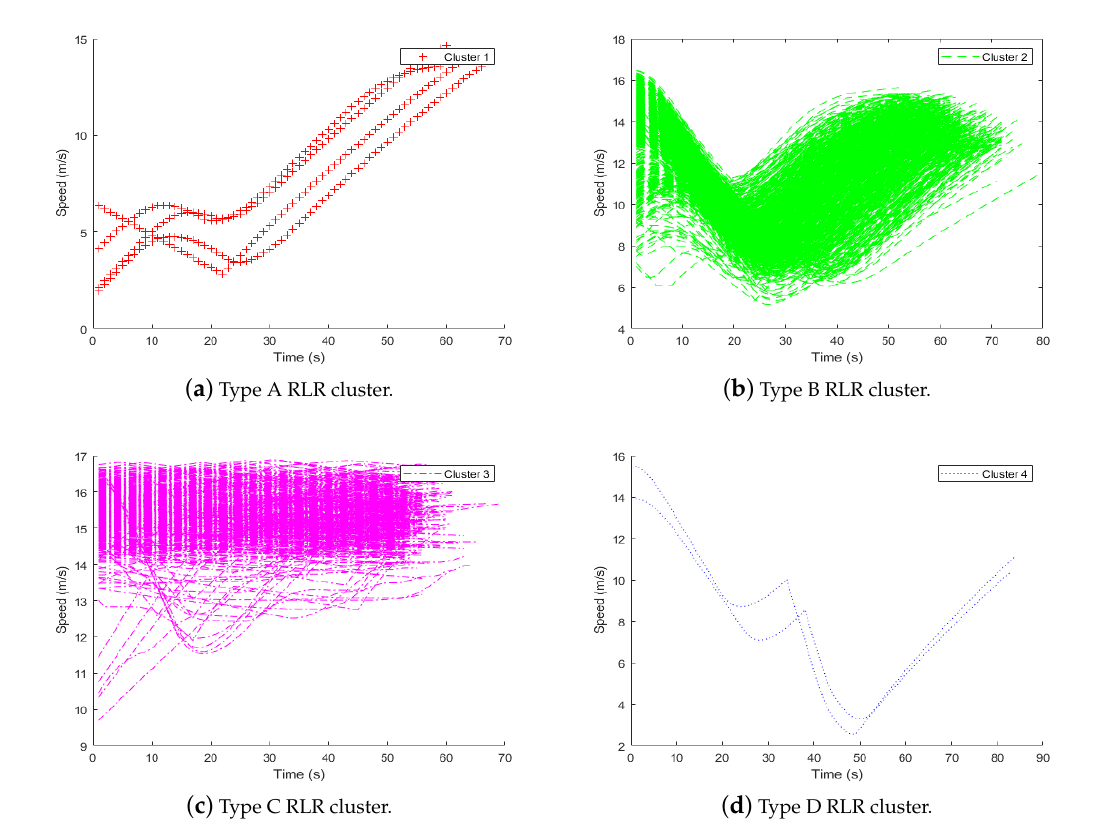
Figure 7. Clustering of RLR traffic dataset through Hierarchical Clustering Analysis